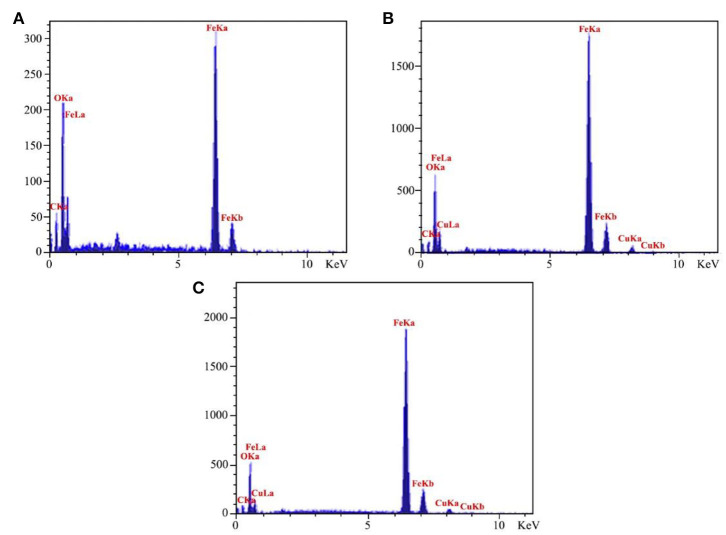
EDX analyses of Fe3O4@PVA (A), Fe3O4@PVA-Cu (B), and recovered Fe3O4@PVA-Cu (C).